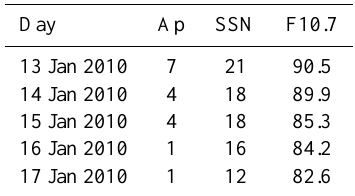
Table 1. Details of parameters during eclipse day and control